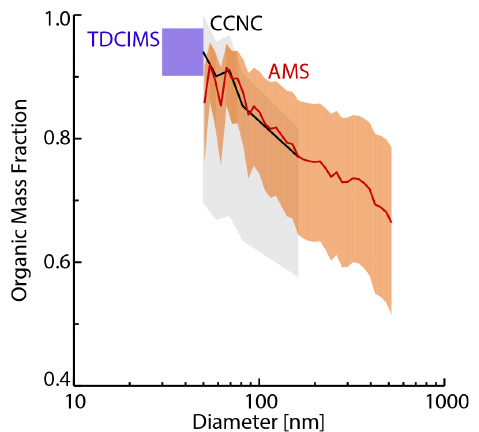
Fig. 3. Aerosol organic mass fraction ( X org ) measured by AMS (red) and TDCIMS (blue) as well as organic mass fraction calcu- lated from size-resolved CCN measurements (black). Gray shading represents the range in X org derived from CCNC data for values of κ org =0–0.15. Orange shading indicates AMS measurement uncer- tainty. The range in TDCIMS-derived X org reflects the uncertainty in the molecular weight of the organic